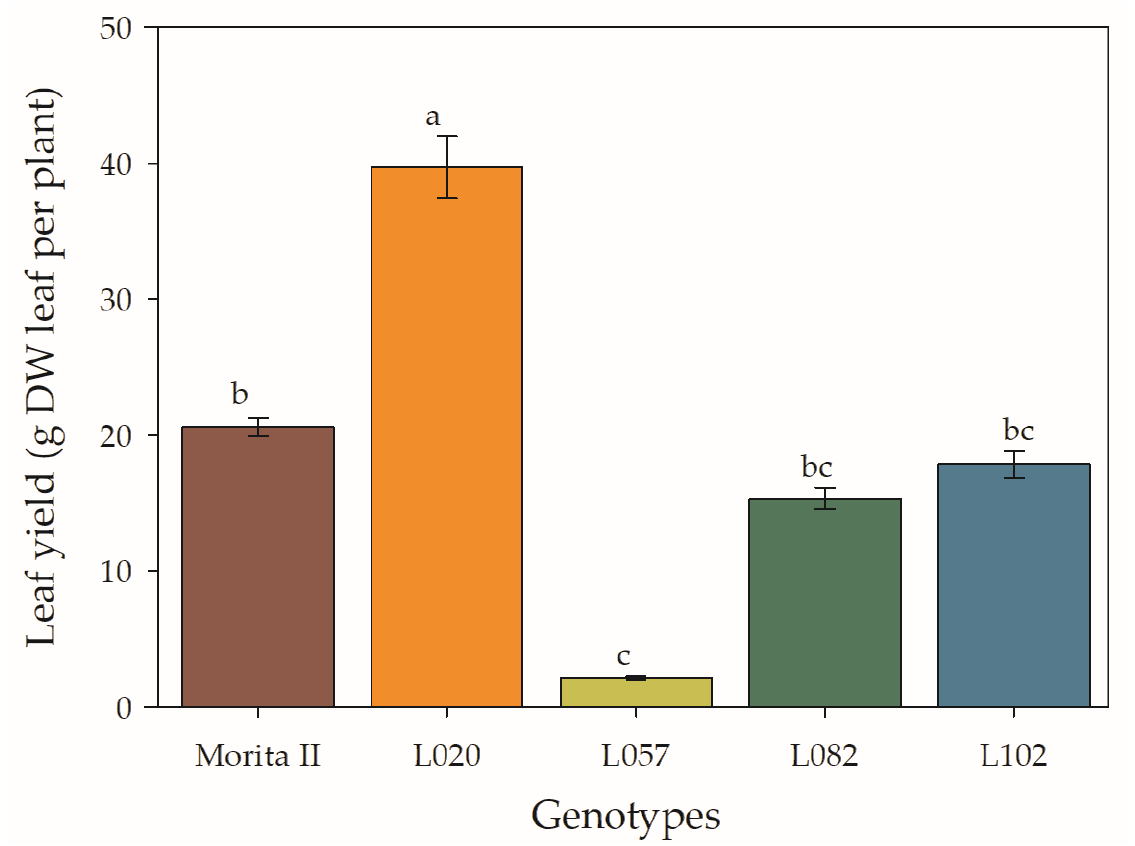
Figure 11. Leaf yield measured in genotypes of Stevia rebaudiana (Morita II, L020, L057, L082, and L102) under land conditions in the complete absence of any plant stress. Means followed by different letters denote statistical significance ( p < 0.001). Means ± SD (n =